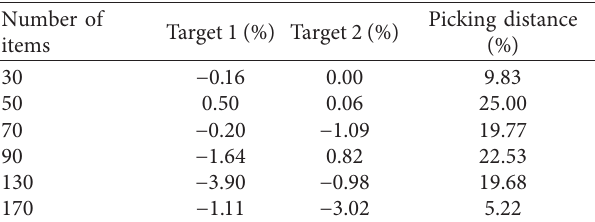
Table 7: The difference between the two optimized values.